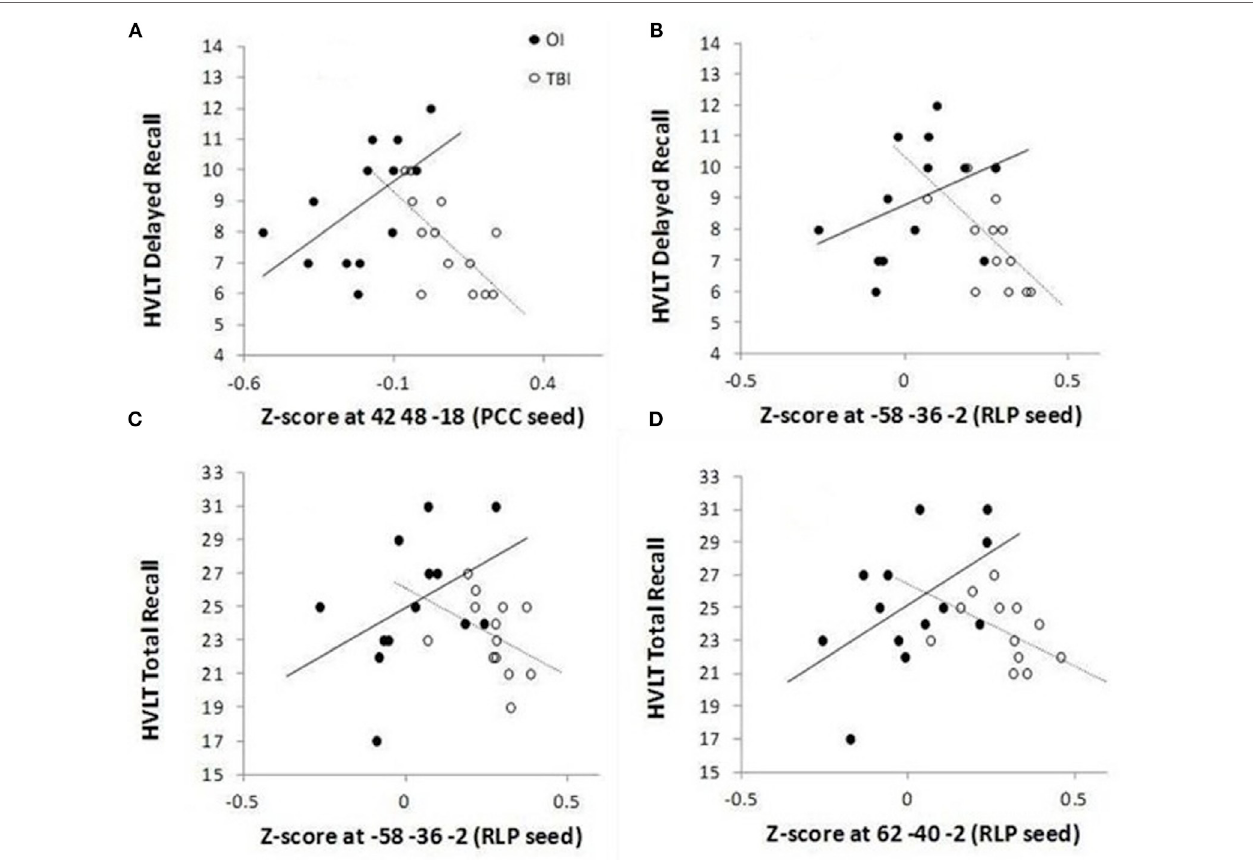
FigUre 2 | group differences for significant correlations between hVlT-r and functional connectivity between the DMn (Pcc seed) and ventral lateral prefrontal cortex (a) and between the DMn (rlP seed) and lateral temporal cortex within the DMn (b–D) . The mean number of words recalled is plotted along the Y -axis for delayed recall (recall without presentation of the words on a single trial 25 min after the three learning trials) [ (a,b) ] and for total recall (sum of words recalled immediately after presentation on each of the three learning trials) [ (c,D)